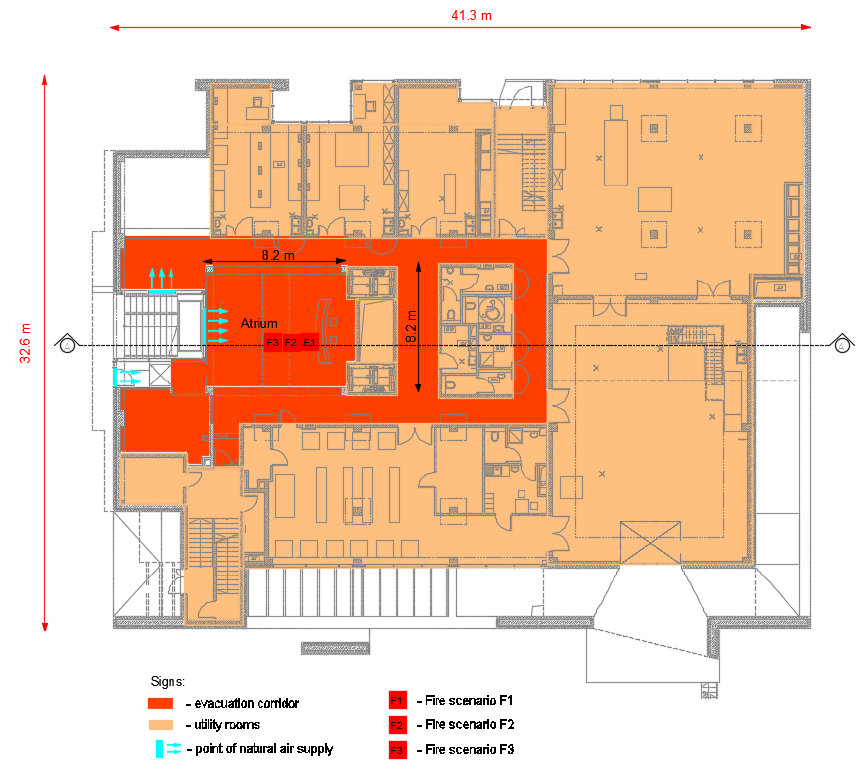
Figure 7. Atrium—Level 0.